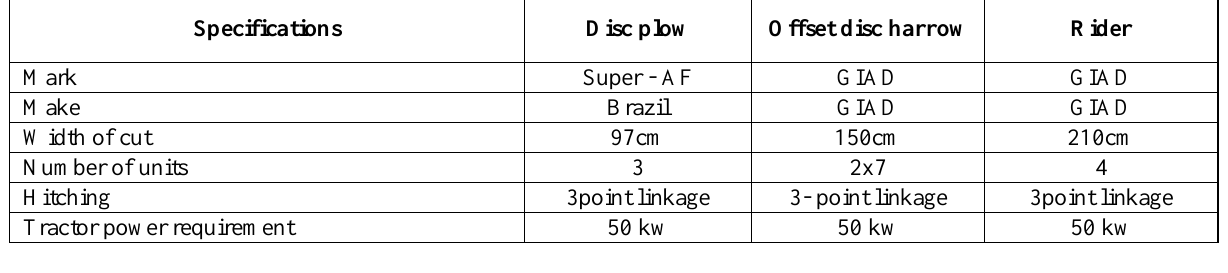
Table 2. Some specifications of implements